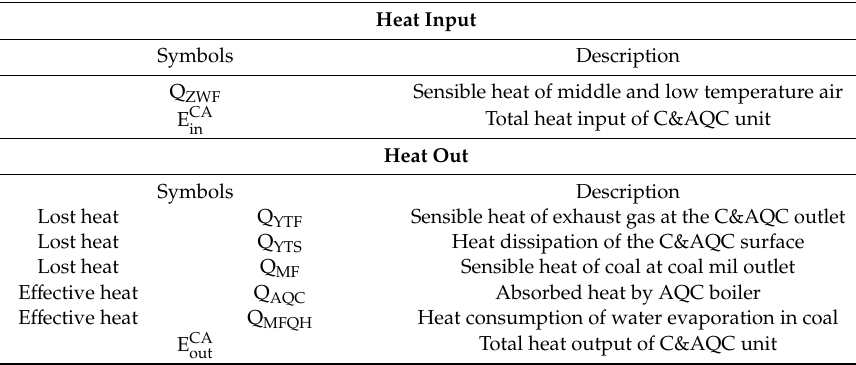
Table 2. Heat balance of the C&AQC unit.